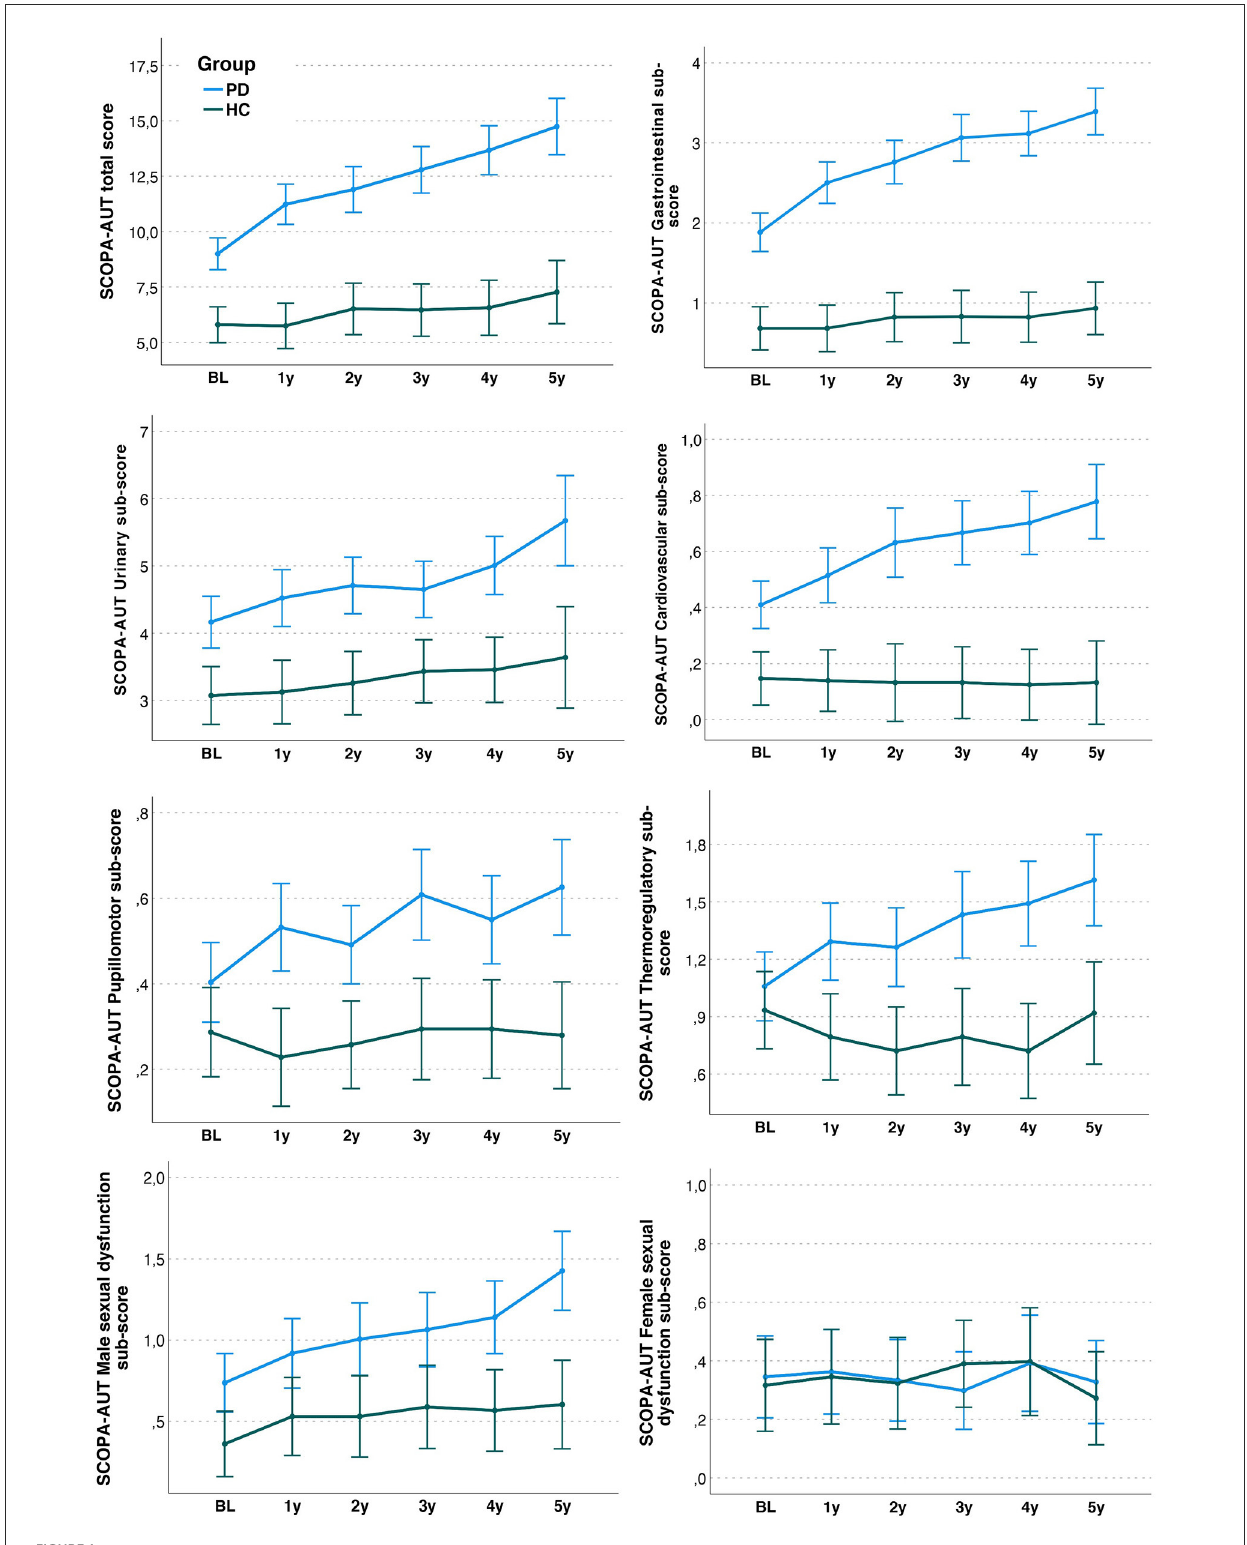
FIGURE1 SCOPA-AUT total and sub-domain scores in Parkinson’s disease (PD) and Healthy Controls (HC) over the first 5 years after baseline. Scores depicted in the panels are based on estimated marginal means (and 95% confidence intervals) from repeated-measures ANOVA